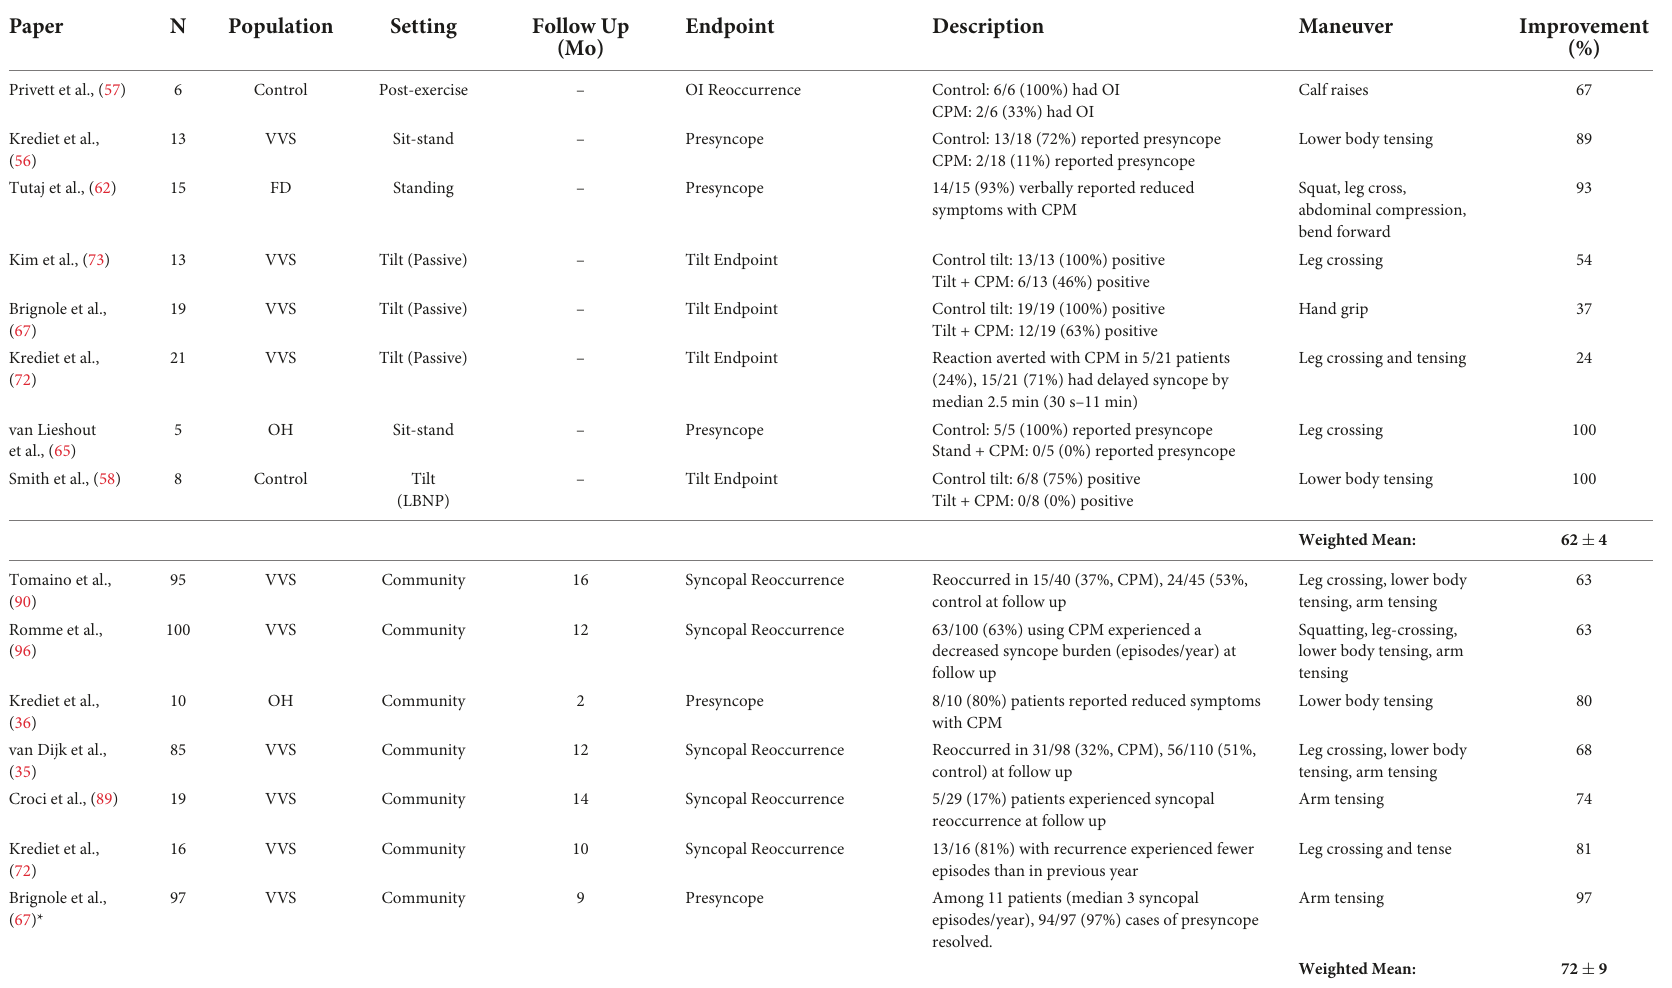
TABLE 3 Improvement of symptoms of syncope and presyncope with counter pressure maneuvers.